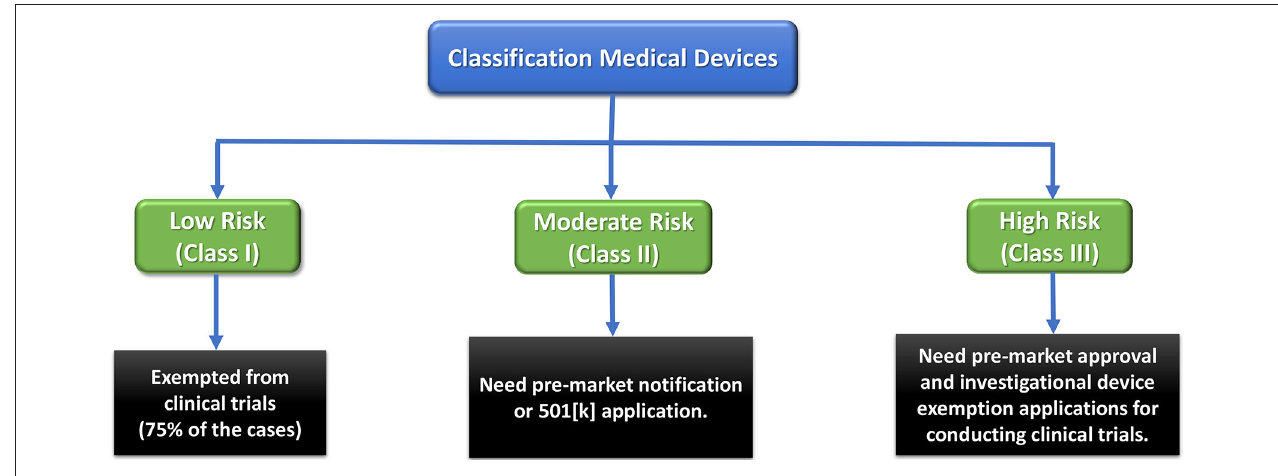
FIGURE 9 | Schematic of FDA medical device approval